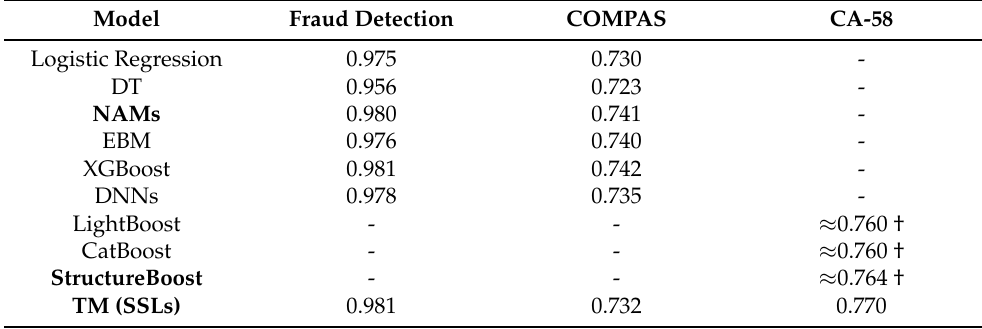
Table 23. Performance (in AUC) comparison against recent state-of-the-art machine learning